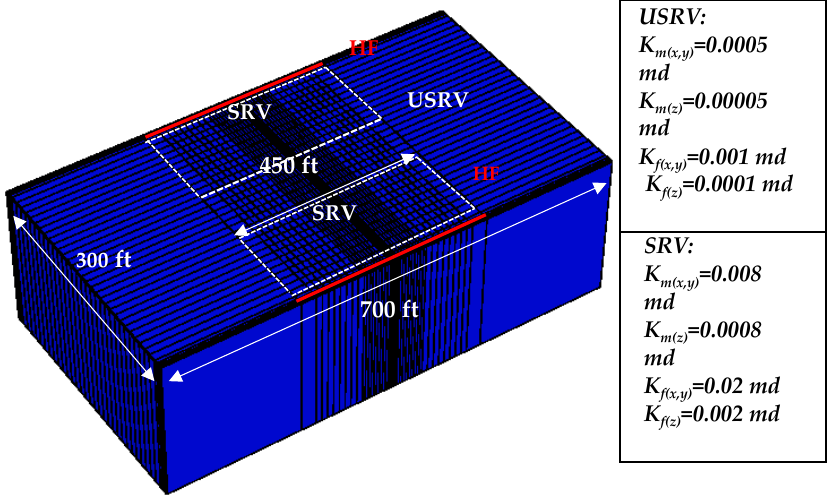
Figure 1. Schematic of two hydraulic fractures (HF) and SRV area with local grid refinement. SRV length is 450 ft. SRV width is variable; depending on fracture